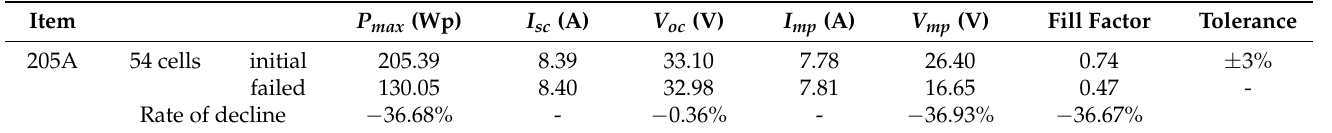
Table 1. Electrical data deviations of the initial and failed module